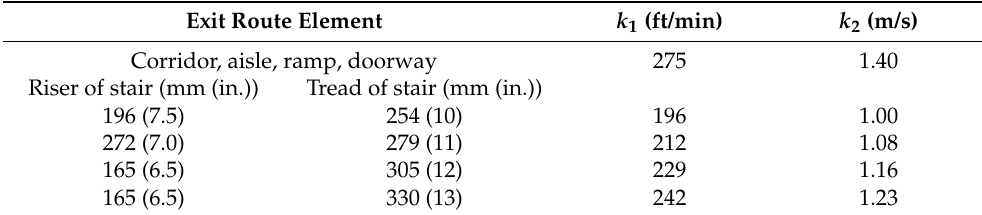
Figure 1. Gait speed graph by age and gender. Table 1. Constants for Equation, Evacuation Speed.